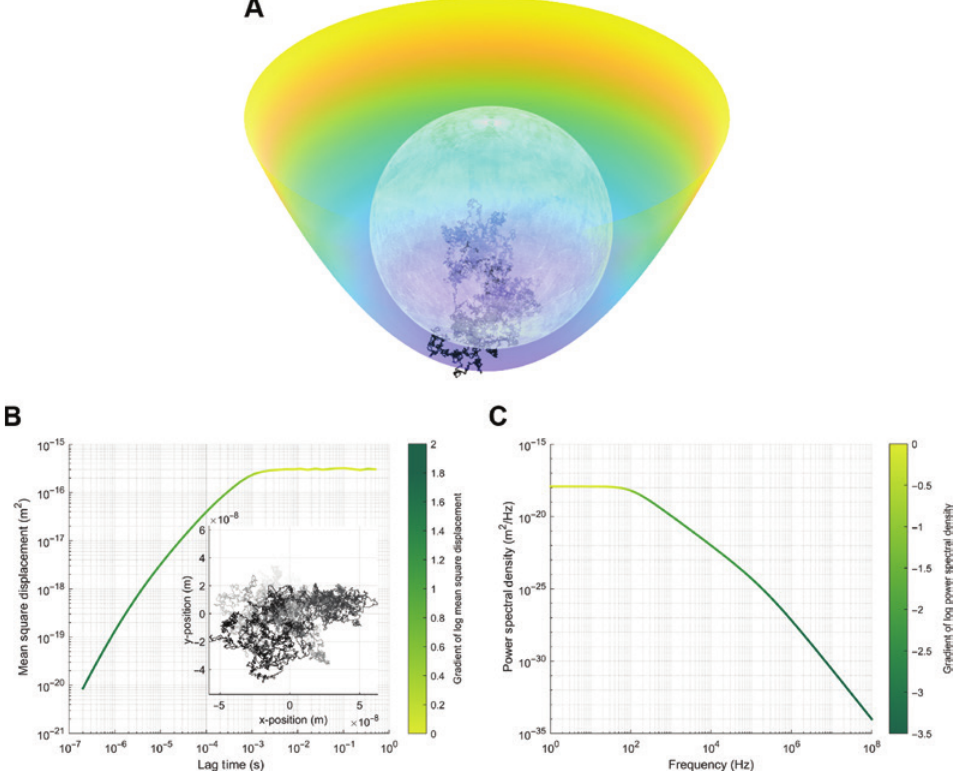
Figure 2: The confinement of an optically trapped particle. (A) Visualization of a linear (Hookean) spring potential in 2D (shaded paraboloid) for an optically trapped particle moving under Brownian motion. (B) MSD and (C) power spectrum of a particle in linear OTs. In B, the Brownian motion of a trapped micron-sized particle is shown in the inset, with shading proportional to the latest sample point. In both B and C, the overdamped harmonic optical trap frequency response is represented by the lightest part of the curves. The Brownian motion of the particle can be resolved in the frequency spectrum and is represented by the middle section of the curves. The ballistic motion of the particle begins to be resolved at higher frequencies and is represented on the plot with the darkest